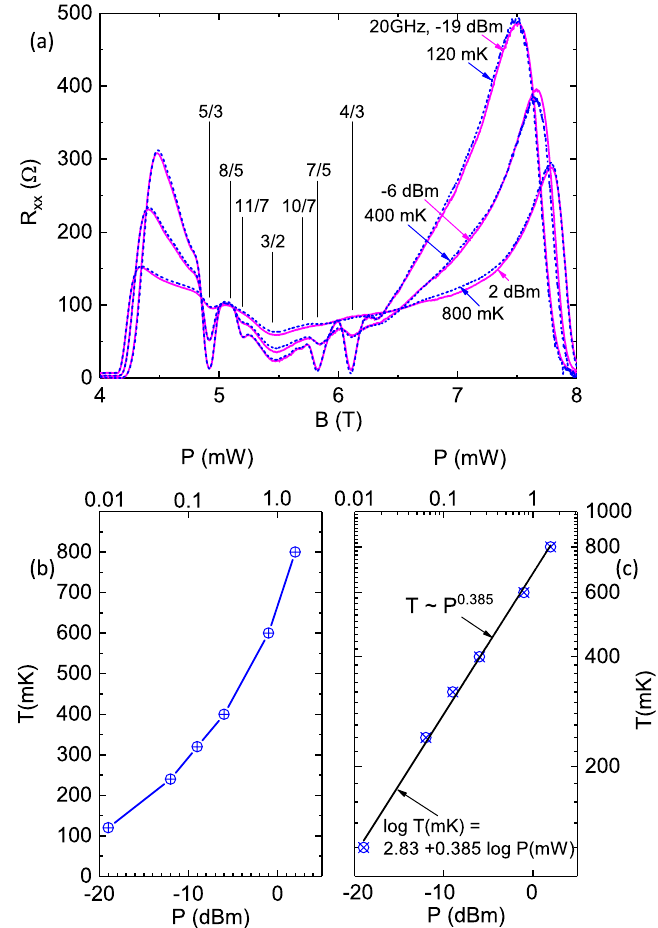
at a given microwave power. ( a ) R xx vs. B traces obtained at various P at base temperature, have been overlaid upon dark R xx vs. B traces obtained at some temperatures, T . The results suggest excellent registry between the power and temperature traces over the entire exhibited span of magnetic fields 4 ≤ B ≤ 8 T . ( b ) The carrier temperatures ( T ) at different microwave powers ( P ), which have been extracted by matching up power traces with temperature traces, as in the top panel. ( c ) A log-log plot suggests simple power law behavior with T ≈ P 0.385